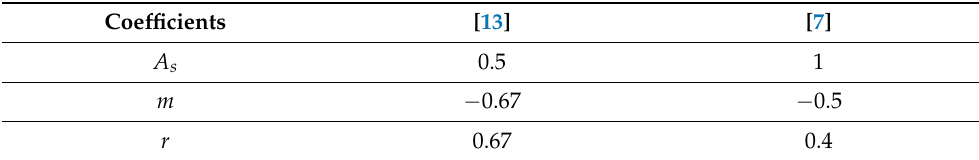
Table 4. Parameters used in the grain size prediction model when static recrystallization takes place. These parameters are obtained by Zhang [16] for high carbon steel and Sellars [8] for carbon manganese steel.